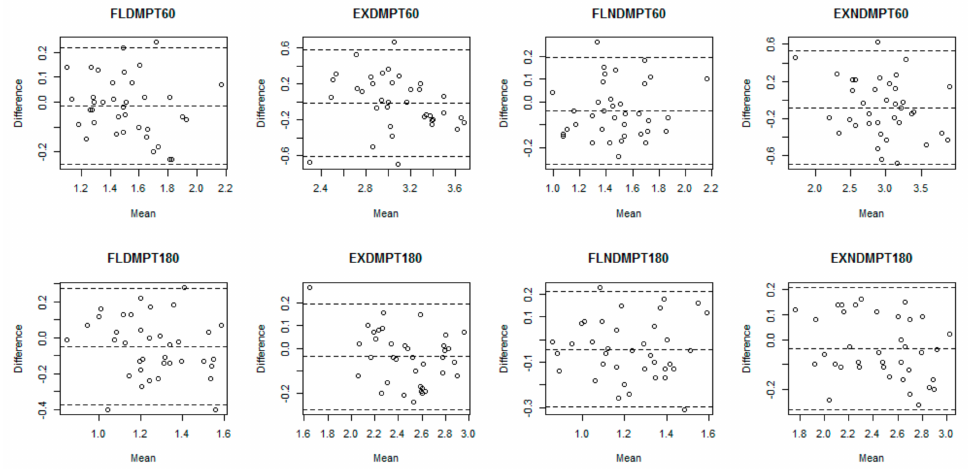
Figure 1. Bland–Altman plots for the intra-rater reliability of the old dynamometer based on the mean of two trials in eight measures. The first dashed line represents Mean–1.96 × SD, the second dashed line represents Mean, and the third dashed line represents Mean + 1.96 × SD. The grey circles indicate differences beyond the 95% confidence